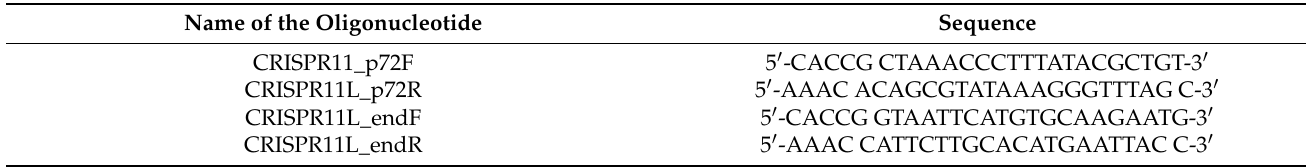
Table 2. Oligonucleotides used for gRNA